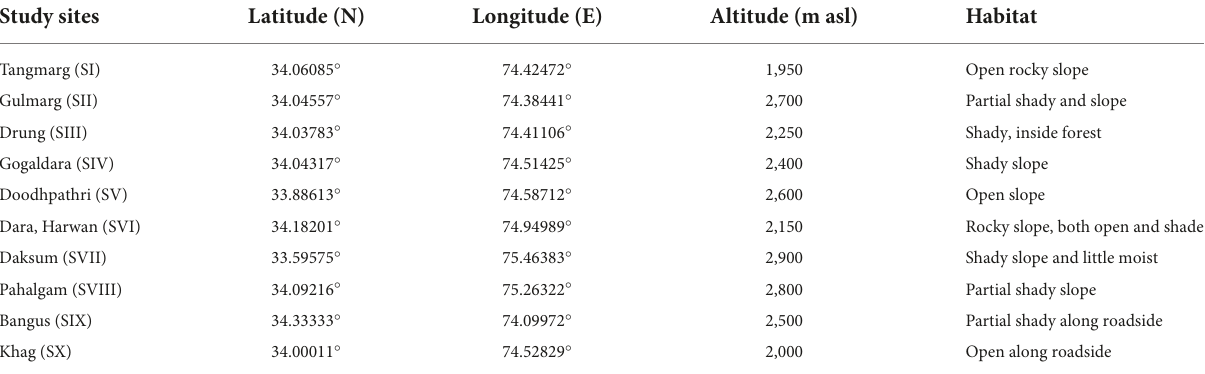
Table 1 Geo-coordinates, altitude and habitat characteristics of the study sites across Kashmir Himalaya, India. Study